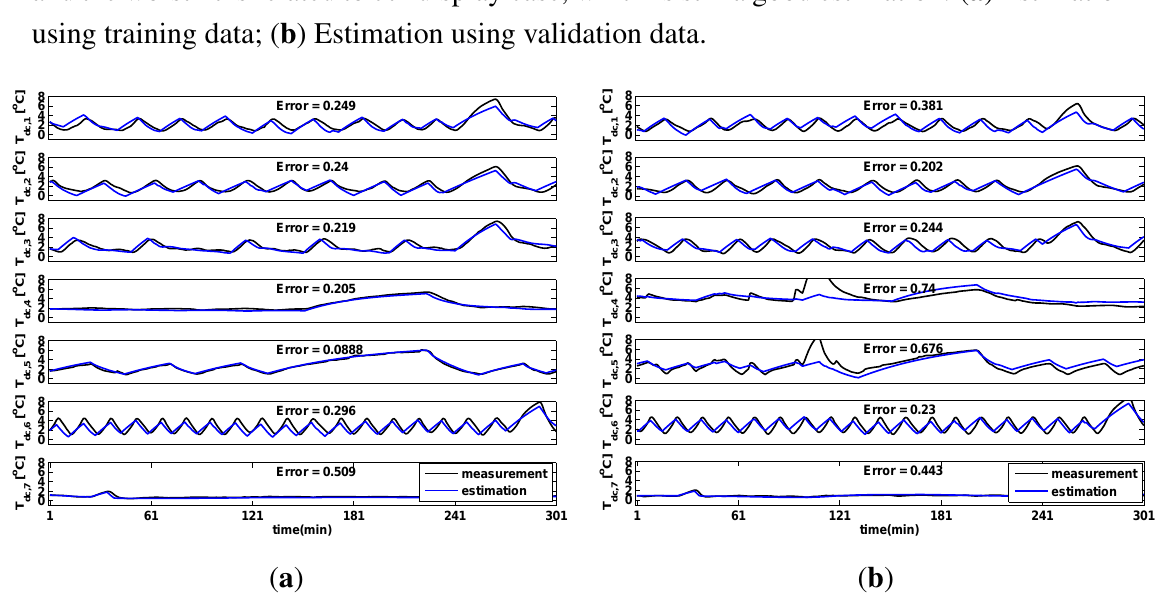
Figure 5. Estimation of the total mass flow from display cases. It is the sum of the mass flows through the expansion valves. ( a ) Estimation using training data; ( b ) Estimation using validation